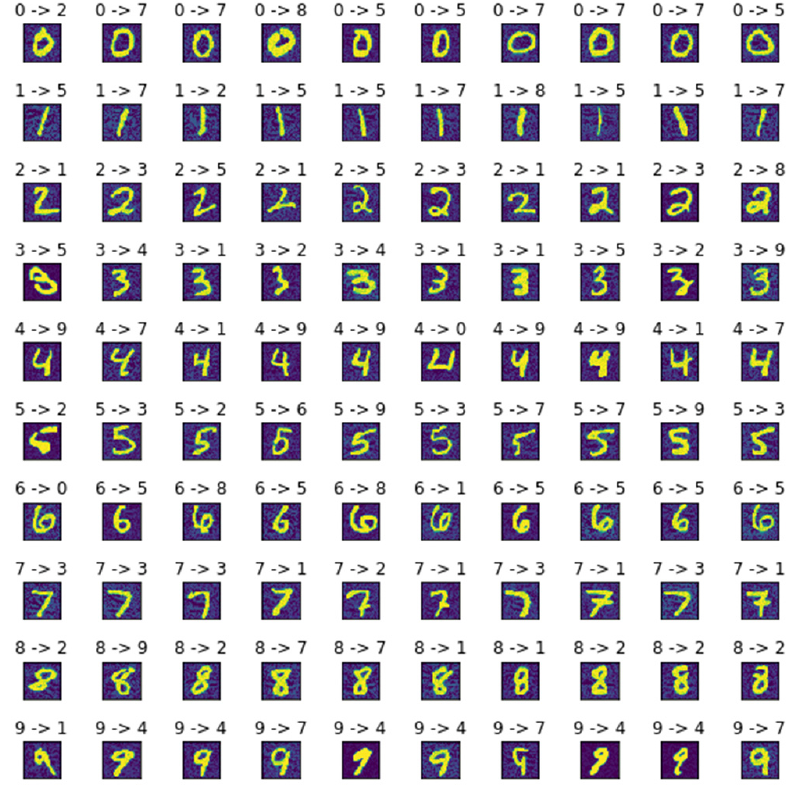
Figure 7. The adversarial examples of SAGM for MNIST.